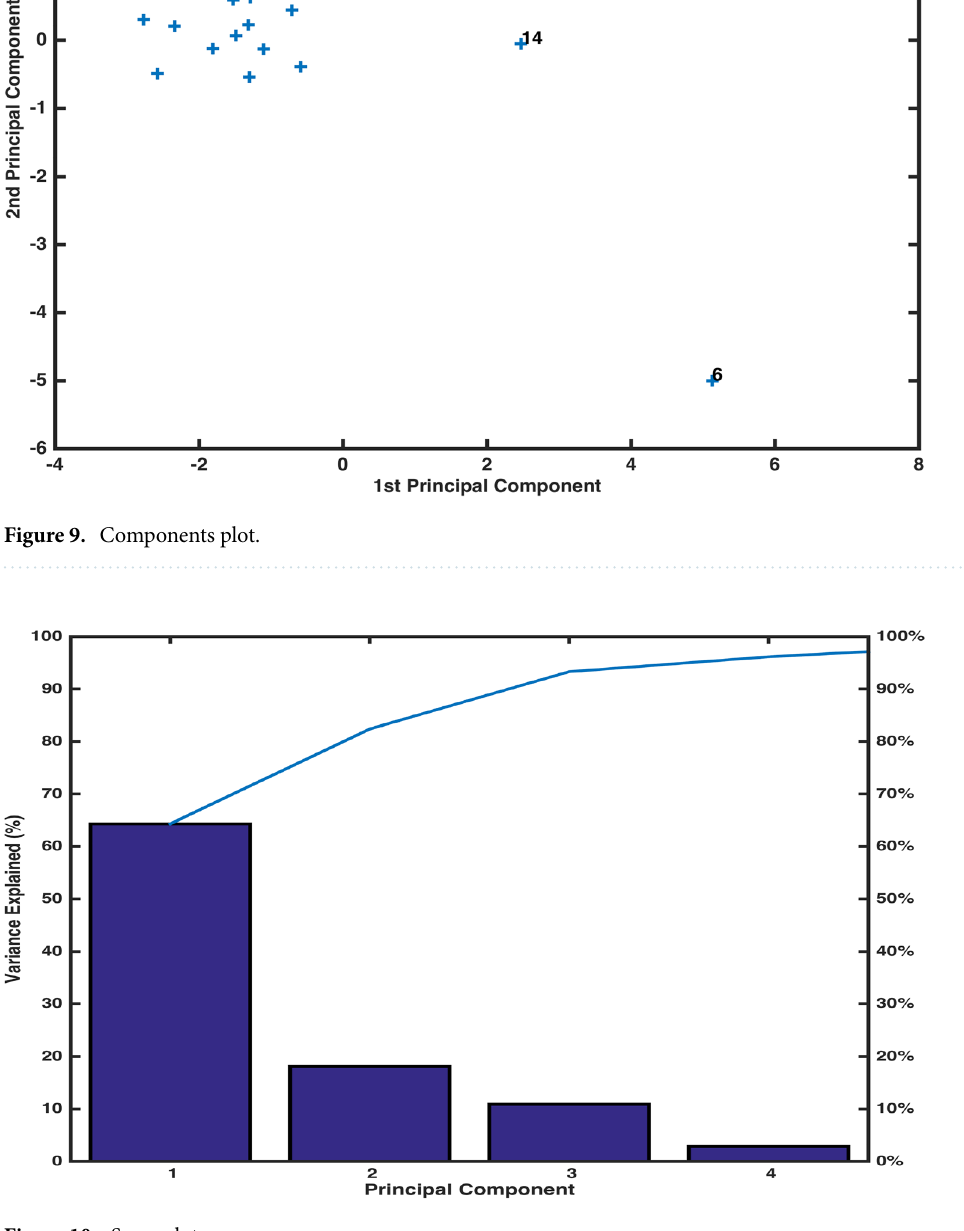
Figure 10. Scree